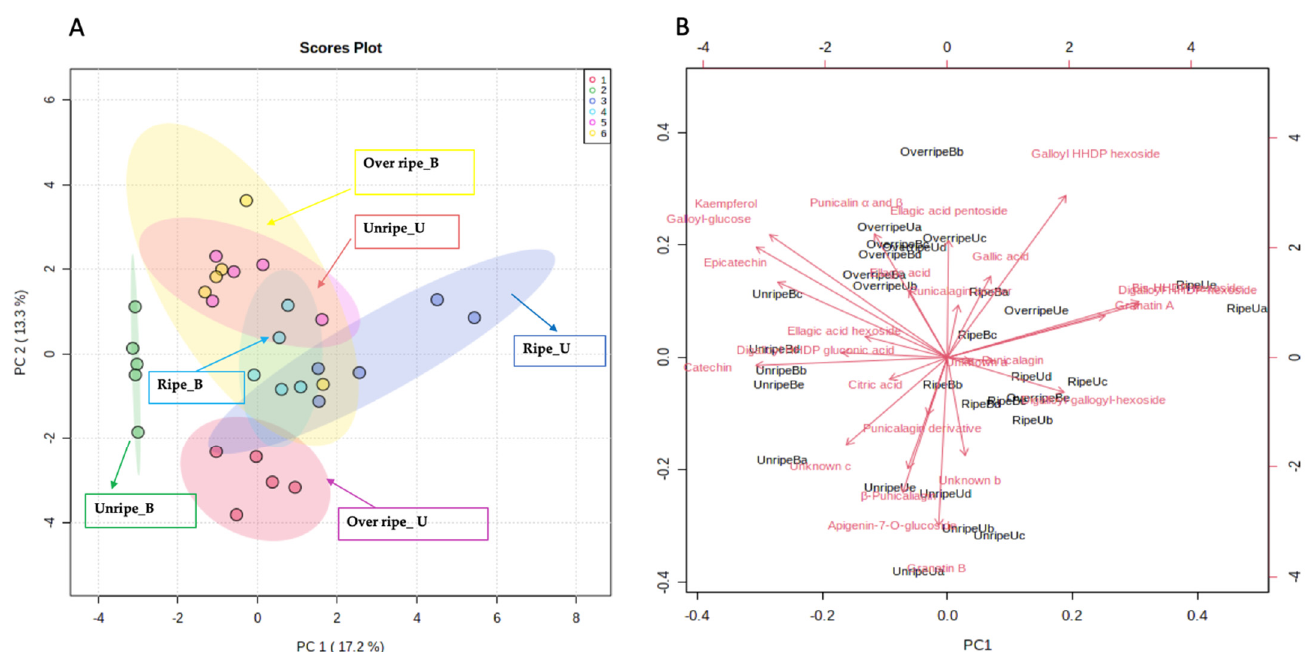
Figure 1. ( A ) Principal component analysis (PCA) score plot and ( B ) Principal component analysis (PCA) biplot showing the potential biomarkers linked to the three different harvest maturities (unripe, ripe, and over ripe) of ‘Wonderful’ pomegranate peel extracts blanched at 80 ◦ C for 3 min. Letters U and B represent unblanched and blanched pomegranate peel extracts at 80 ◦ C for 3 min. Table 5. Individual phenolic and flavonoid concentration in blanched pomegranate peel (‘Wonderful’ unripe, ripe, and over ripe harvest maturity).